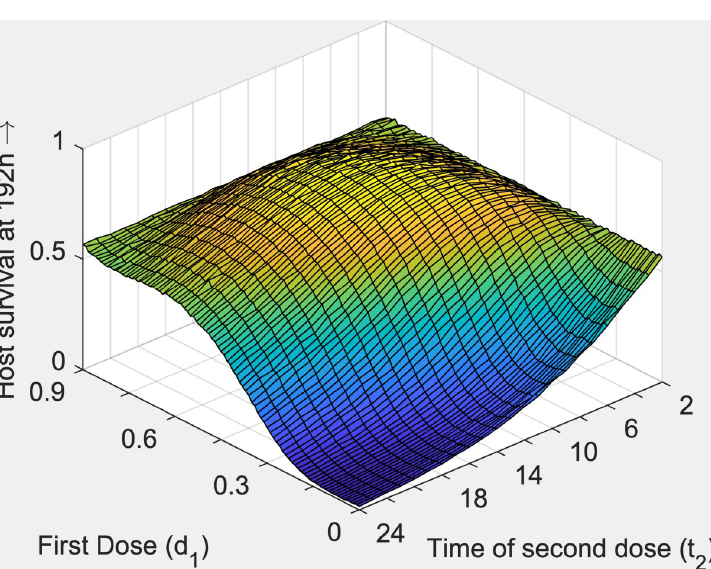
Fig 4. Two-dose treatment regimen with the first dose d survival at 192 h is plotted against the size of the first dose d 1 : and the time of the second dose t 2 . Model runs =